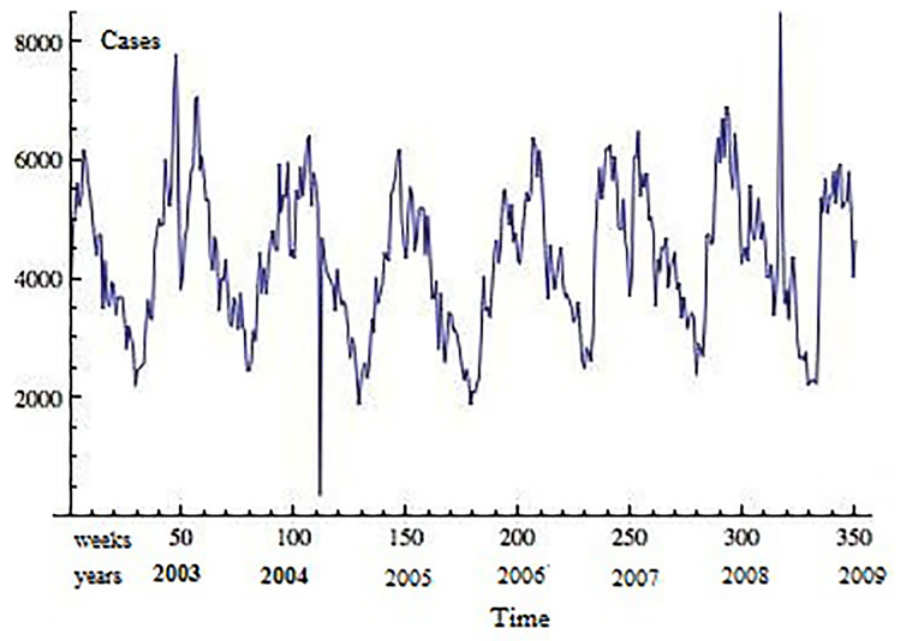
Fig 1. Weekly number of acute respiratory infections reported to the State Health Services Epidemiology Department, San Luis Potosí, México (2003 – 2009).